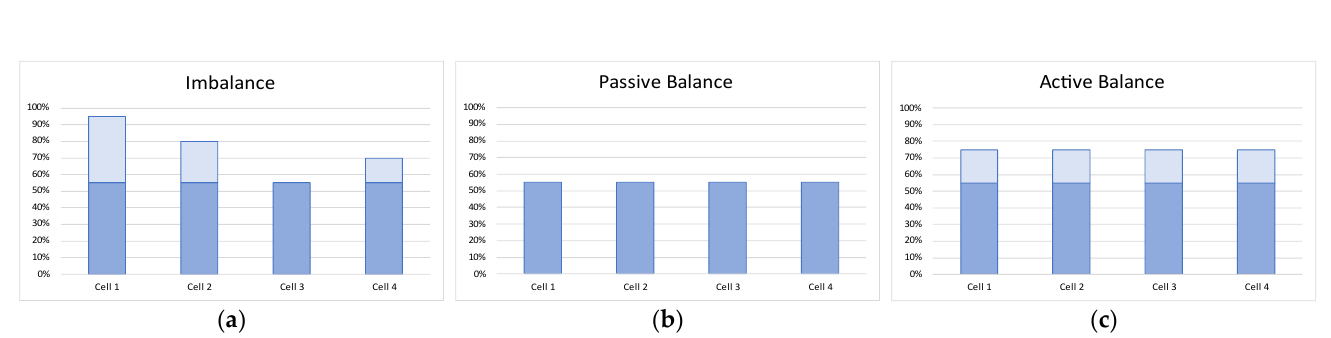
Figure 22. Comparison of the two types of balancing: ( a ) initial cells’ SoC; ( b ) final cells’ SoC with passive balance; ( c ) final cells’ SoC with active balance.